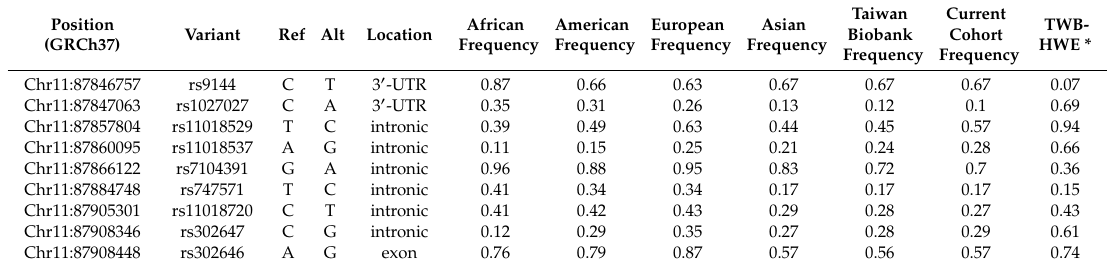
Table 2. Basic characteristics of the RAB38 single-nucleotide polymorphisms (SNPs). Position (GRCh37)